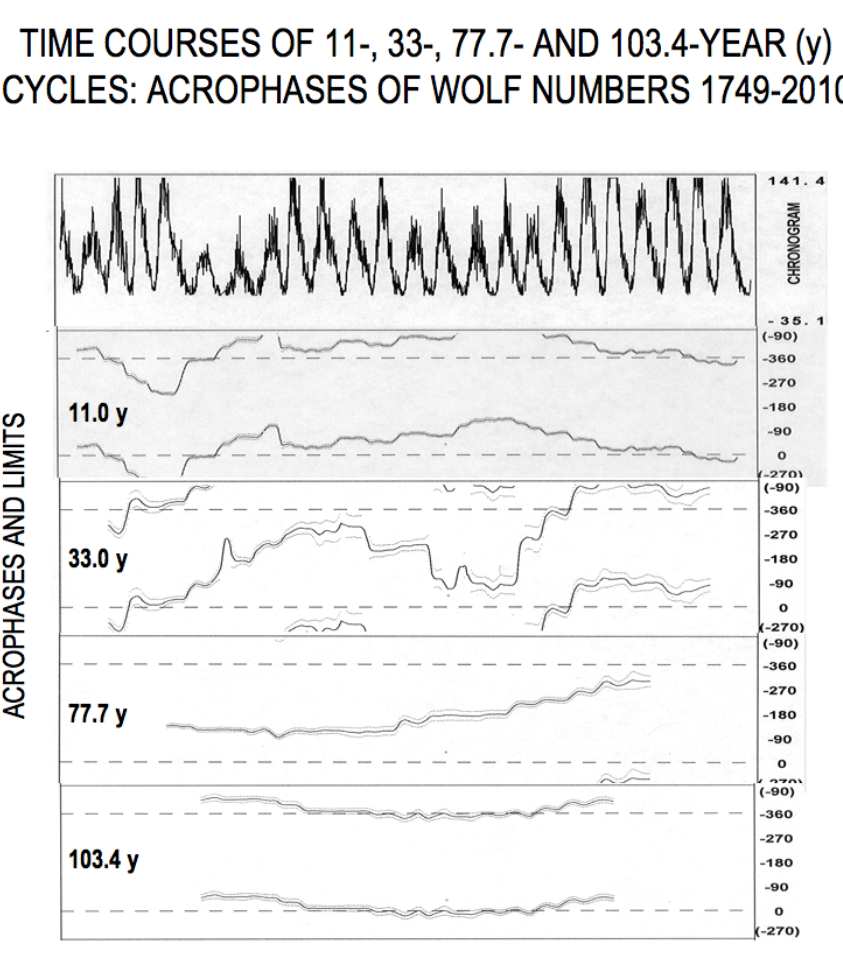
Figure 4. The 33-year fit’s variability of acrophase (row 3), as compared to that of other periods during 260 years (rows 2, 4 and 5), is much greater. This circumstance requires a glocal approach and may obscure results in studies based on the analyses only of fractions of data (locally) or only of all data at a given time (globally), in either of which the information is incomplete, possibly misleading, and is often used only to check on the global result, without realizing the changing (aeolian) nature of solar activity. ©